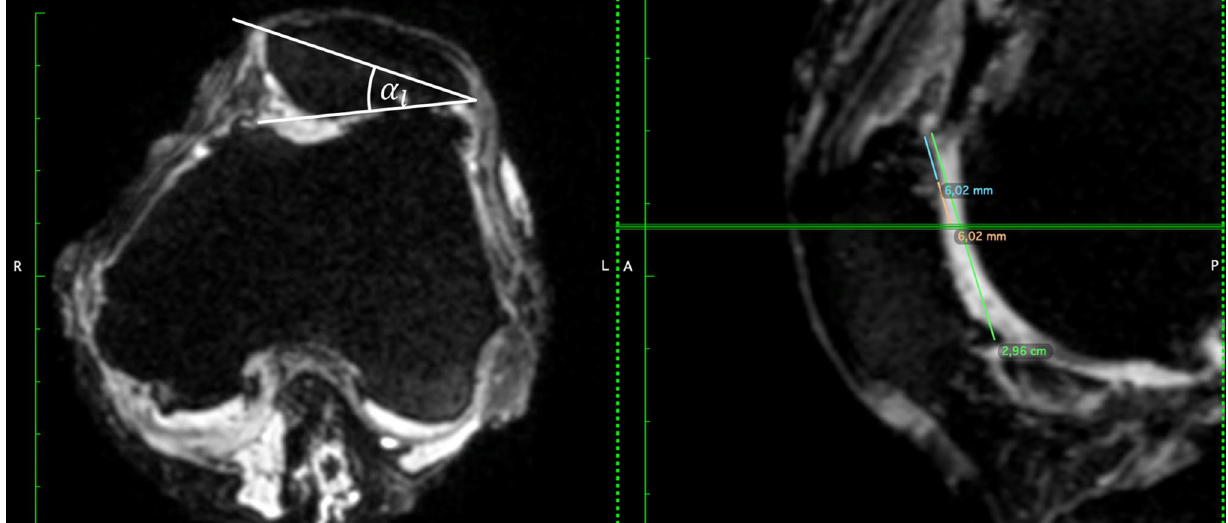
Figure 2. Visualization of the angles measured in the MRI data of the native knee joint. Left: patello-femoral joint in view from distal with measured lateral patellar facet angle. Right: sagittal view with the actual plane for the distal view (green). The angle drawn in the left image was measured in four parallel and equidistant planes of the patella.